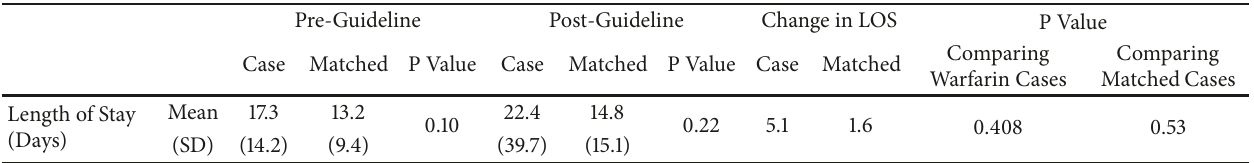
Table 4: A comparison of pre- and post-guideline length of stay between warfarinised and nonwarfarinised matched patients. Pre-Guideline